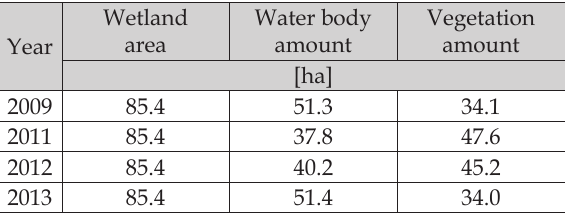
Table 4. The variation in vegetation amount and beel area, after calculating pixel